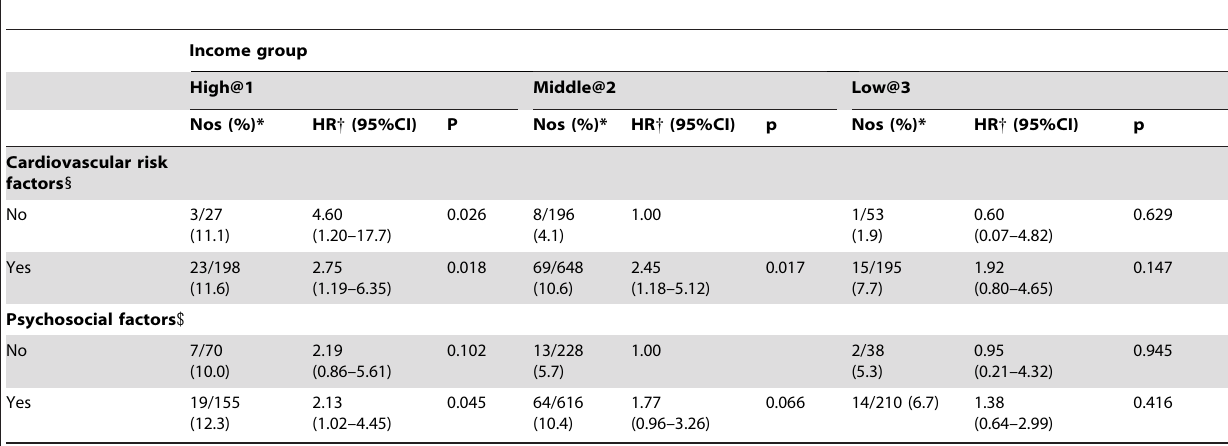
Table 4. Hazard ratios (HR) for incident diabetes by income group and cardiovascular or psychosocial risk factors in older people – Hefei cohort study,